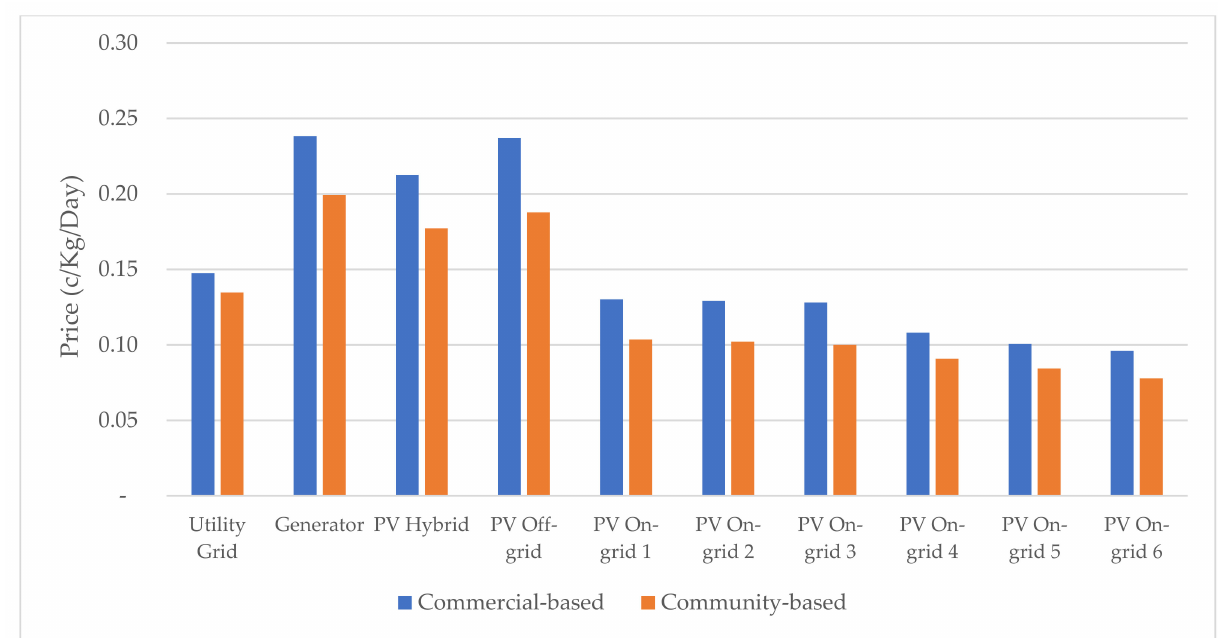
Figure 13. Commercial and Community-based Cold Storage Rental Prices